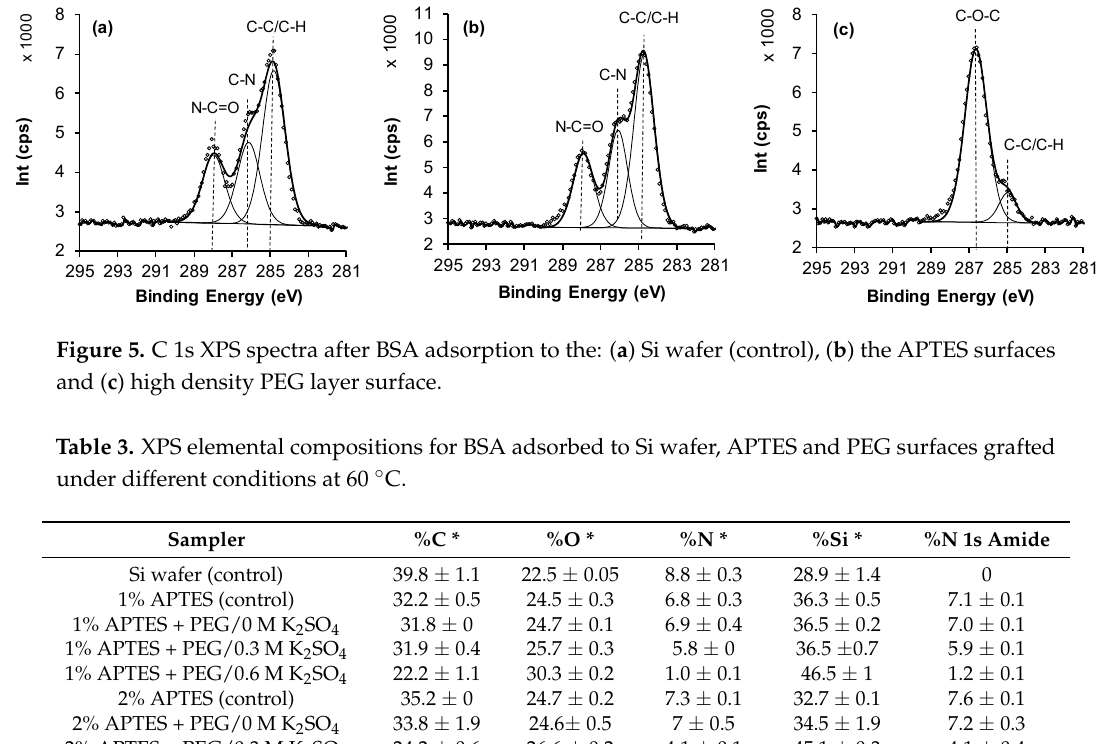
Figure 4. AFM topography images recorded for: ( a ) 1% APTES, ( b ) 1% APTES_PEG/0.6 M K 2 SO 4 /60 °C, ( c ) 2% APTES, ( d ) 2% APTES_PEG/0.6 M K 2 SO 4 /60 °C, ( e ) 4% APTES, and ( f ) 4% APTES_PEG/0.6 M K 2 SO 4 /60 °C (OD600nm = 0.48). All z -scales were equal to 5 nm.